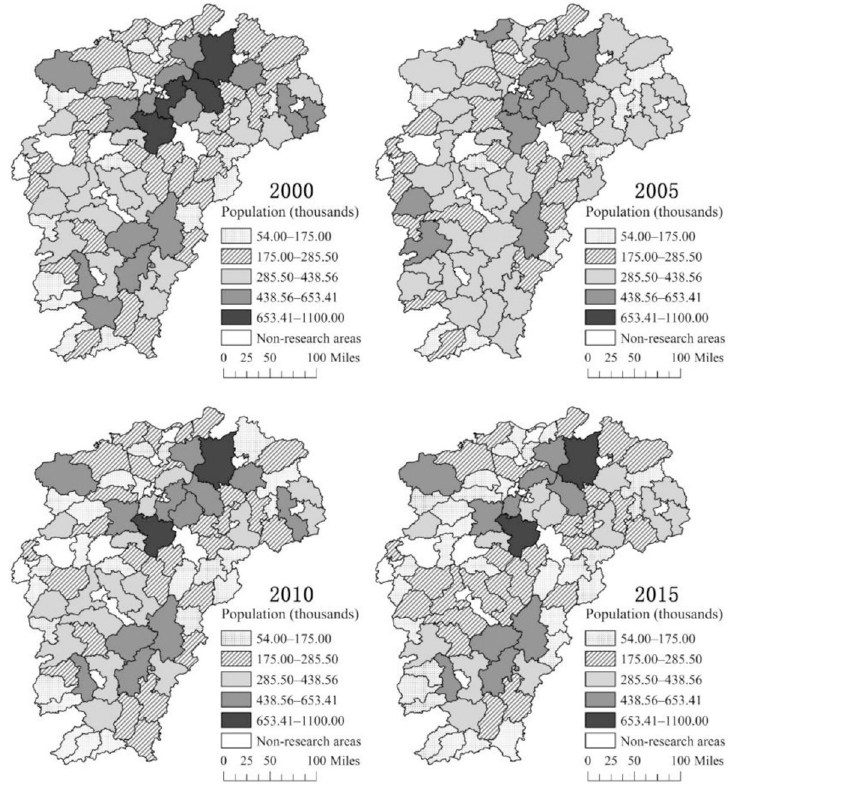
Fig 2. Spatial distribution of the rural population in Jiangxi